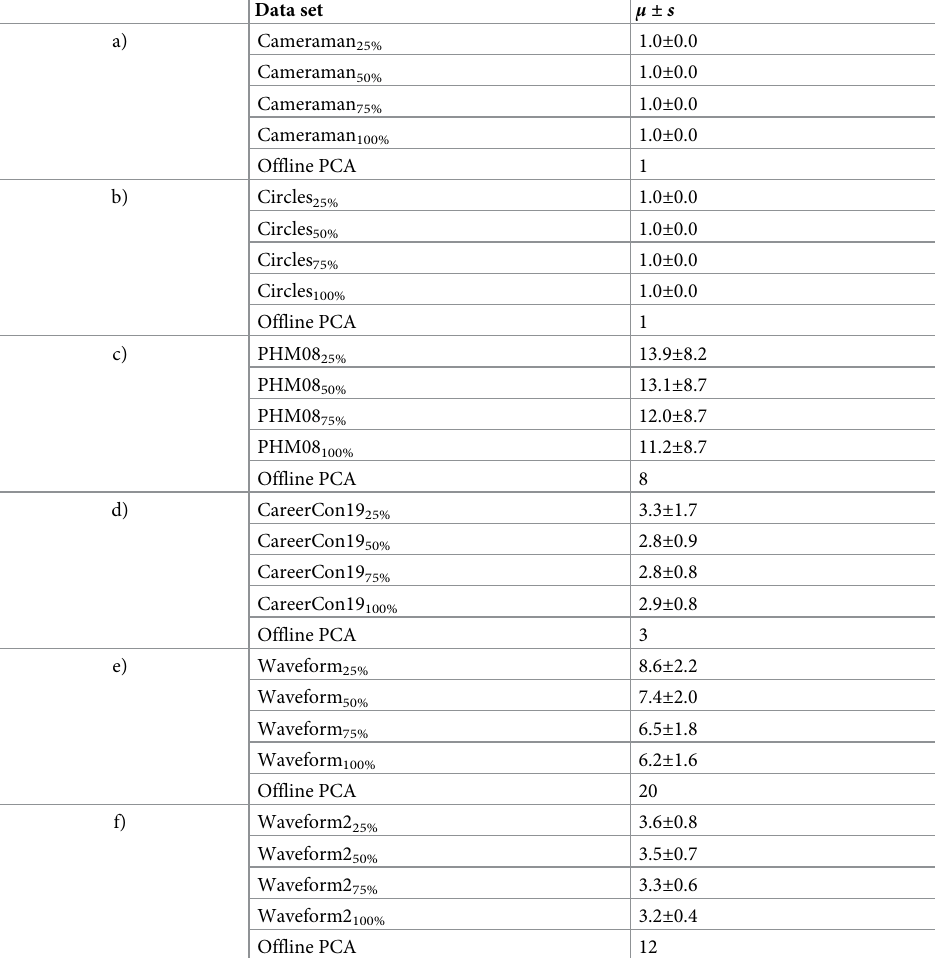
Table 2. Results obtained with the online eigenvalue-one criterion compared with the offline